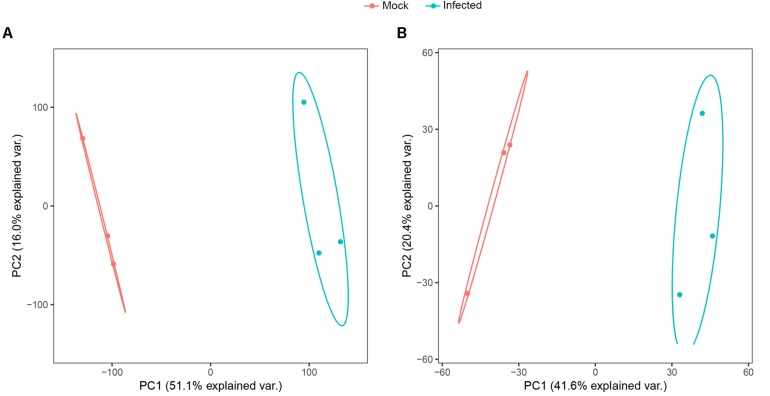
Principal component analysis score plot of transcriptome (A) and proteome (B) profiles.